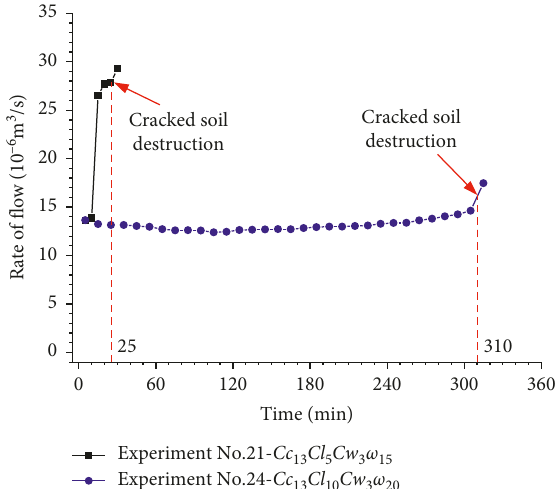
Figure 13: Change curve of the crack rate of flow that increases to ∞ m 3